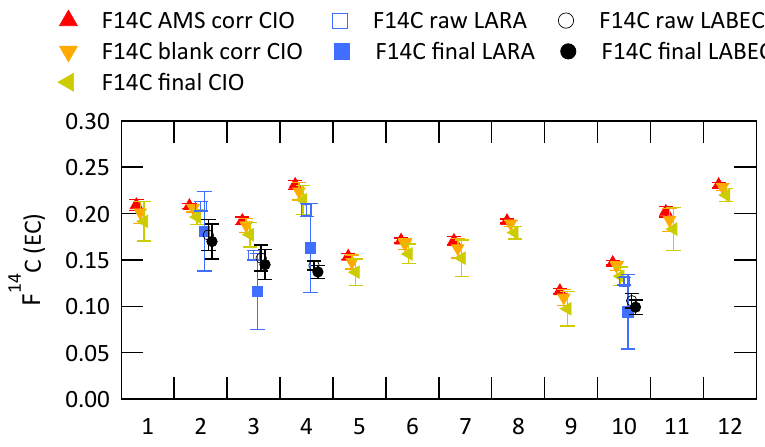
Figure 5. Fraction modern of EC measured at CIO with different applied correction steps: AMS correction-normalization, correction for isotopic fractionation and background contamination correction (F14C AMS corr CIO); AMS correction + sampling blank correction (F14C blank corr CIO); AMS correction + sampling blank correction + OC charring correction (F14C final CIO); and fraction modern of EC measured at LARA and LABEC before (raw) and after (final) application of the corrections listed in Table